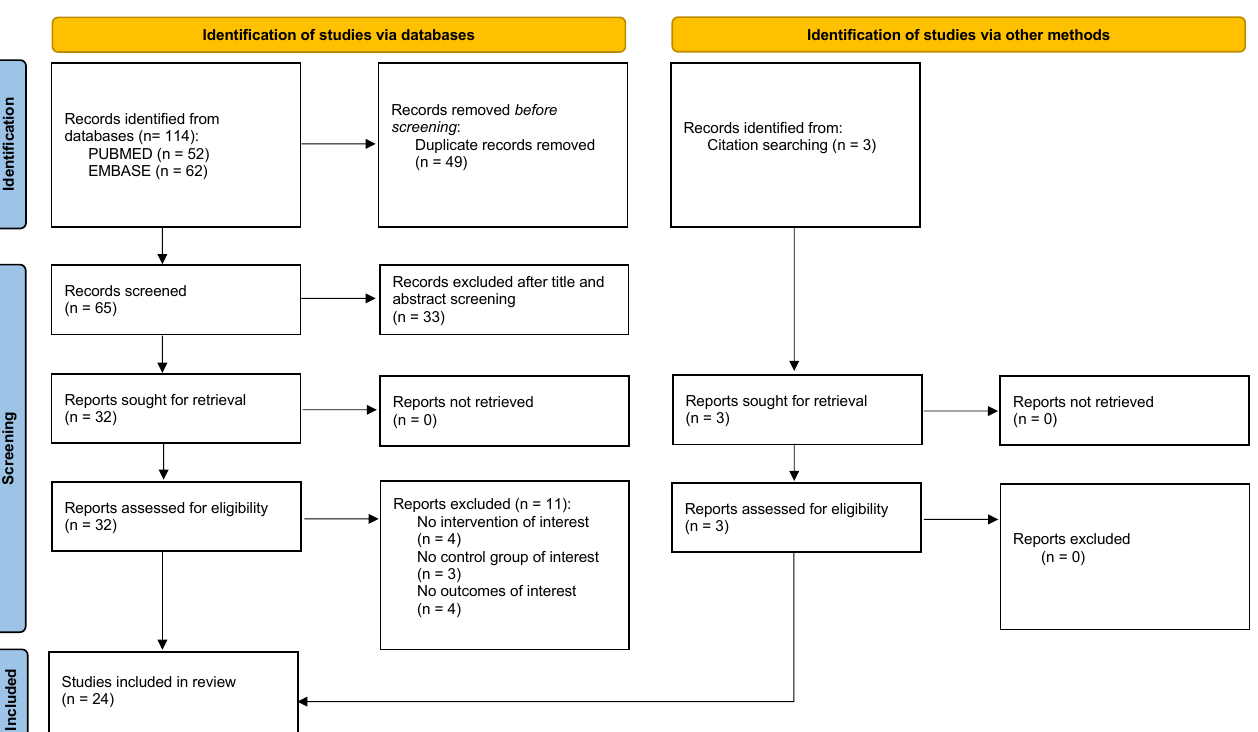
Figure 1. PRISMA flow-diagram [61] illustrating the literature search